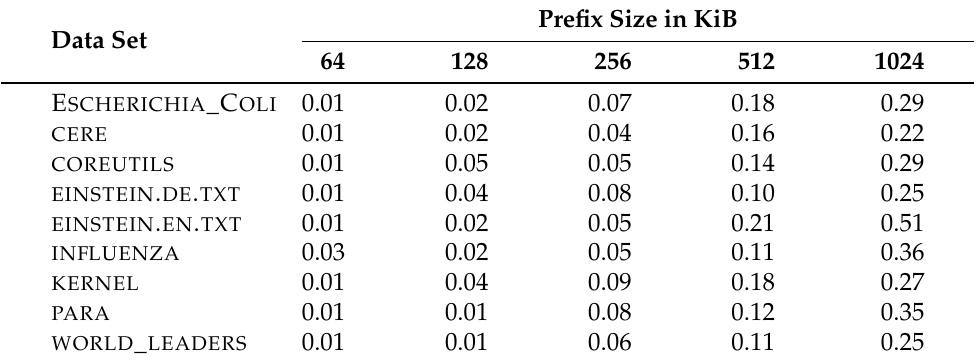
Table 2. Experimental evaluation of the implementation of Navarro. Table entries are running times in